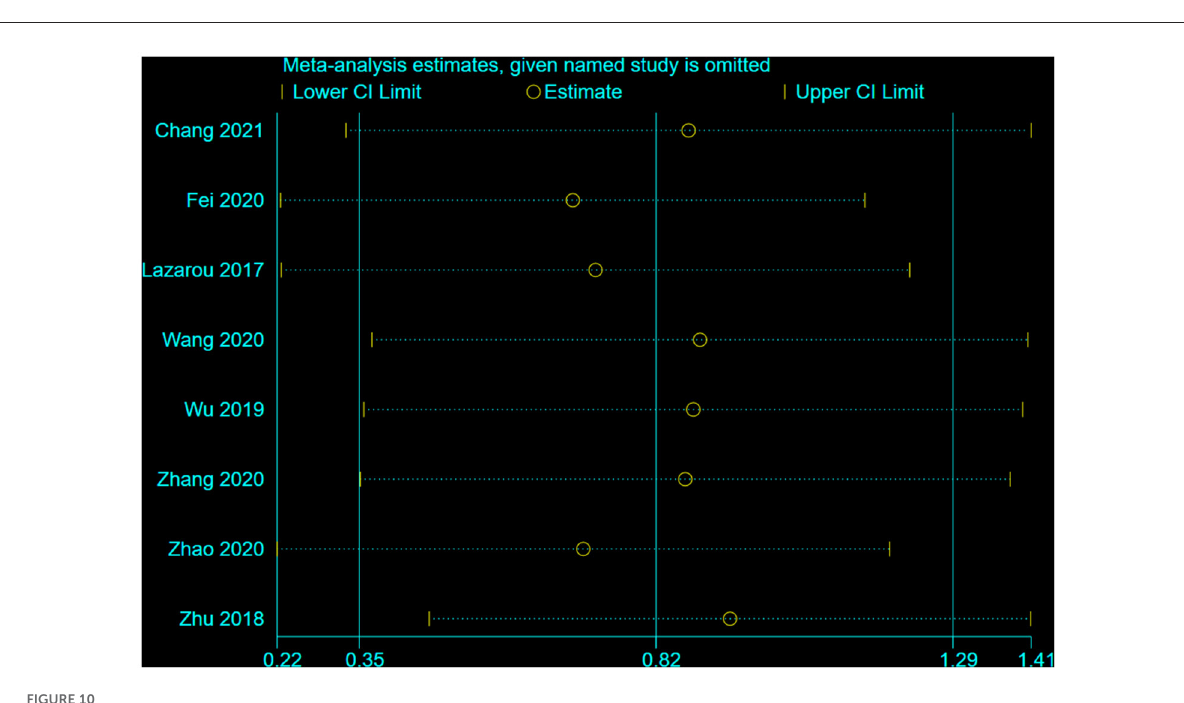
engages individuals’ visuospatial skills (de Natale et al., 2017; Douka et al., 2019). One possible explanation is that the nature of dance places a high demand on the spatial cognitive processes